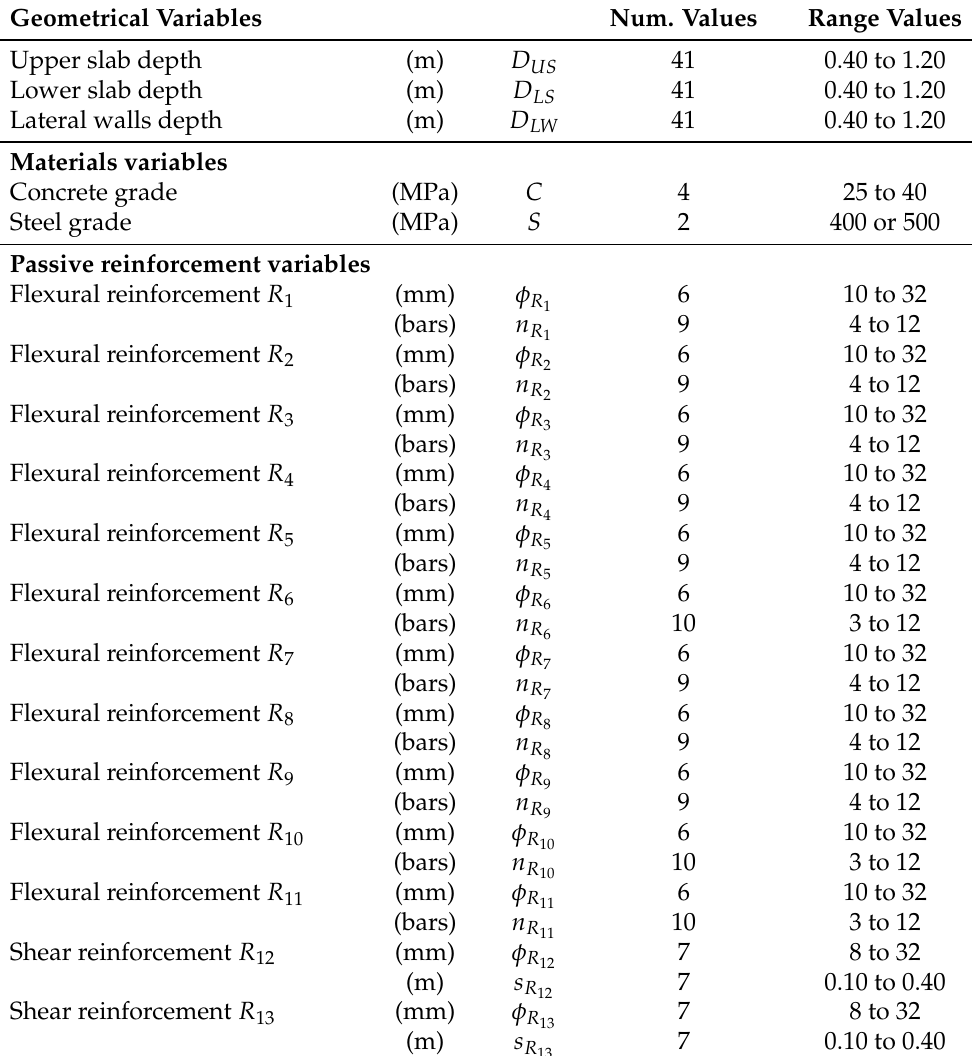
Table 3. Variables cosidered in the optimization